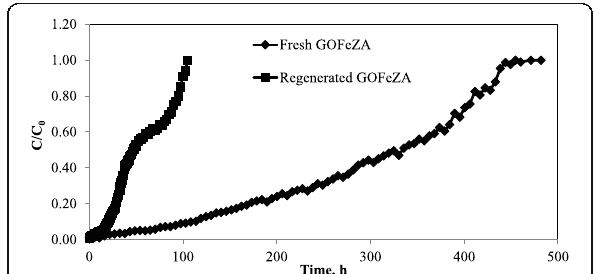
Fig. 11 Fixed-bed column study on fresh and regenerated